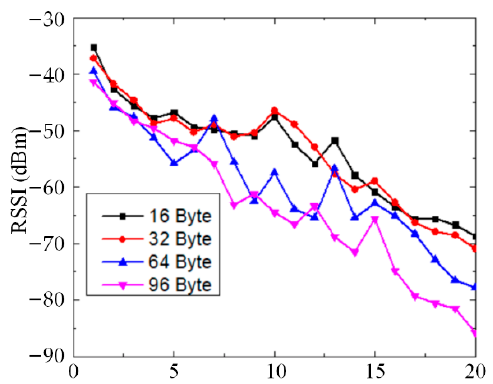
Figure 15. RSSI values from WSN communication with different payloads.